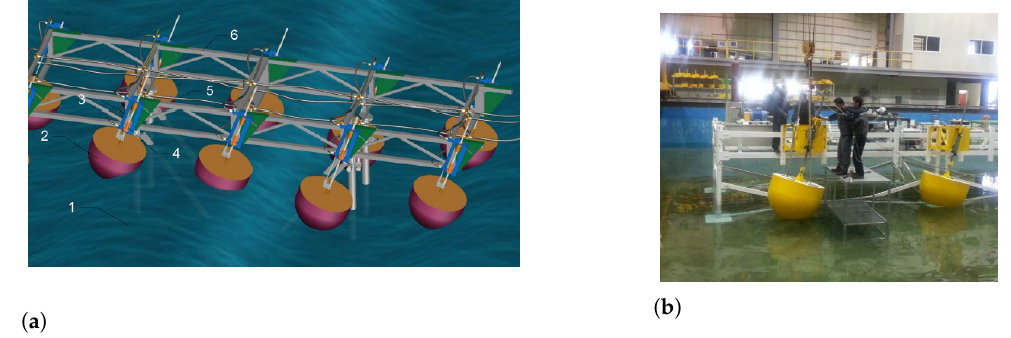
Figure 13. Experimental setup used by Do et al., adapted with permission from Ref. [43], 2018, Do et al.: ( a ) 3D rendering of the WEC array layout; ( b ) RIMS’s wave basin setup picture.